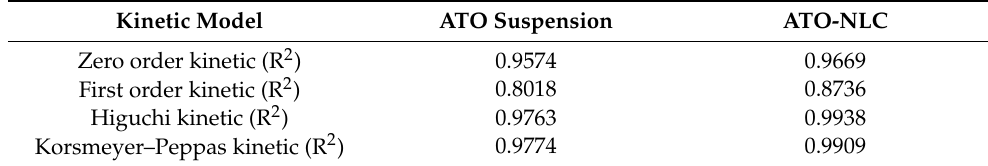
Table 5. Different kinetic modeling for illustrating ATO release from suspension and NLC.